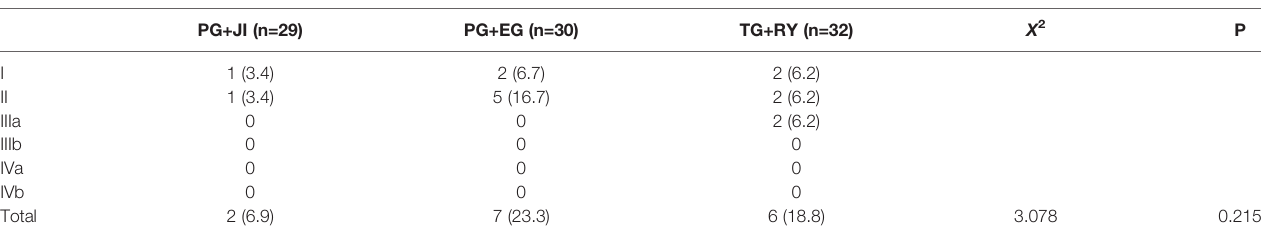
TABLE 3 | Postoperative complications (Clavien-Dindo classi fi cation).